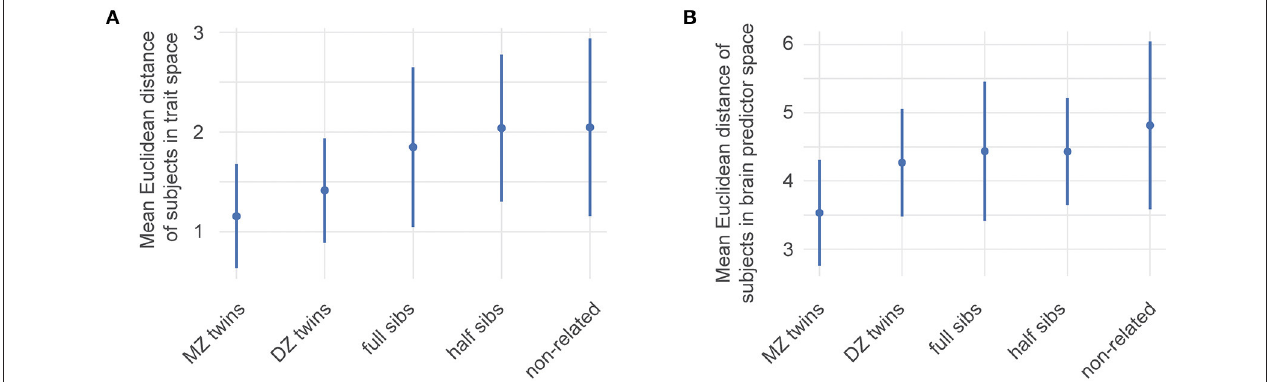
FIGURE 4 | Estimates of the genetic influence on ability traits. HCP family structure data were used to identify genetic influences among the ability traits and brain networks contributing to them. Mean Euclidean distance of pairs of data points within the HCP data. MZ: monozygotic twins, DZ: dizygotic twins Error bars correspond to one standard deviation of distances of the corresponding subset. (A) Distances between pairs of subjects within the four-dimensional ability trait space. (B) Distances between subjects using the space spanned by the 19 relevant features from Figure 3 . A higher genetic overlap leads to smaller